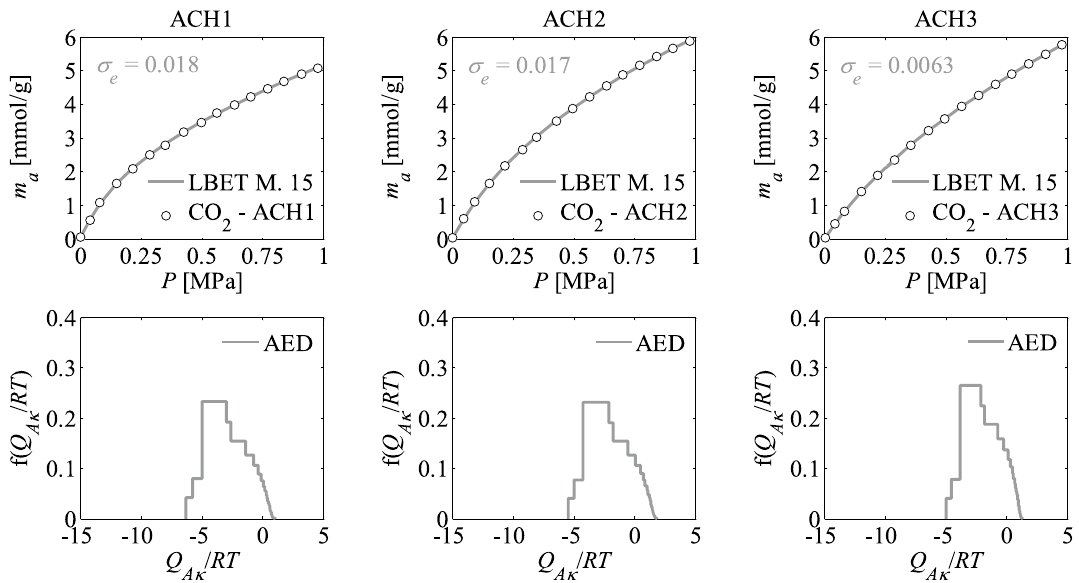
Figure 7. Carbon dioxide adsorption isotherms and adsorption energy distributions (AED) obtained by applying the LBET method to the experimental data for the activated carbons developed by chemical activation of Pine cones with KOH, at the highest temperature (ACH R ) with the different impregnations ratios ( R = 1, 2,